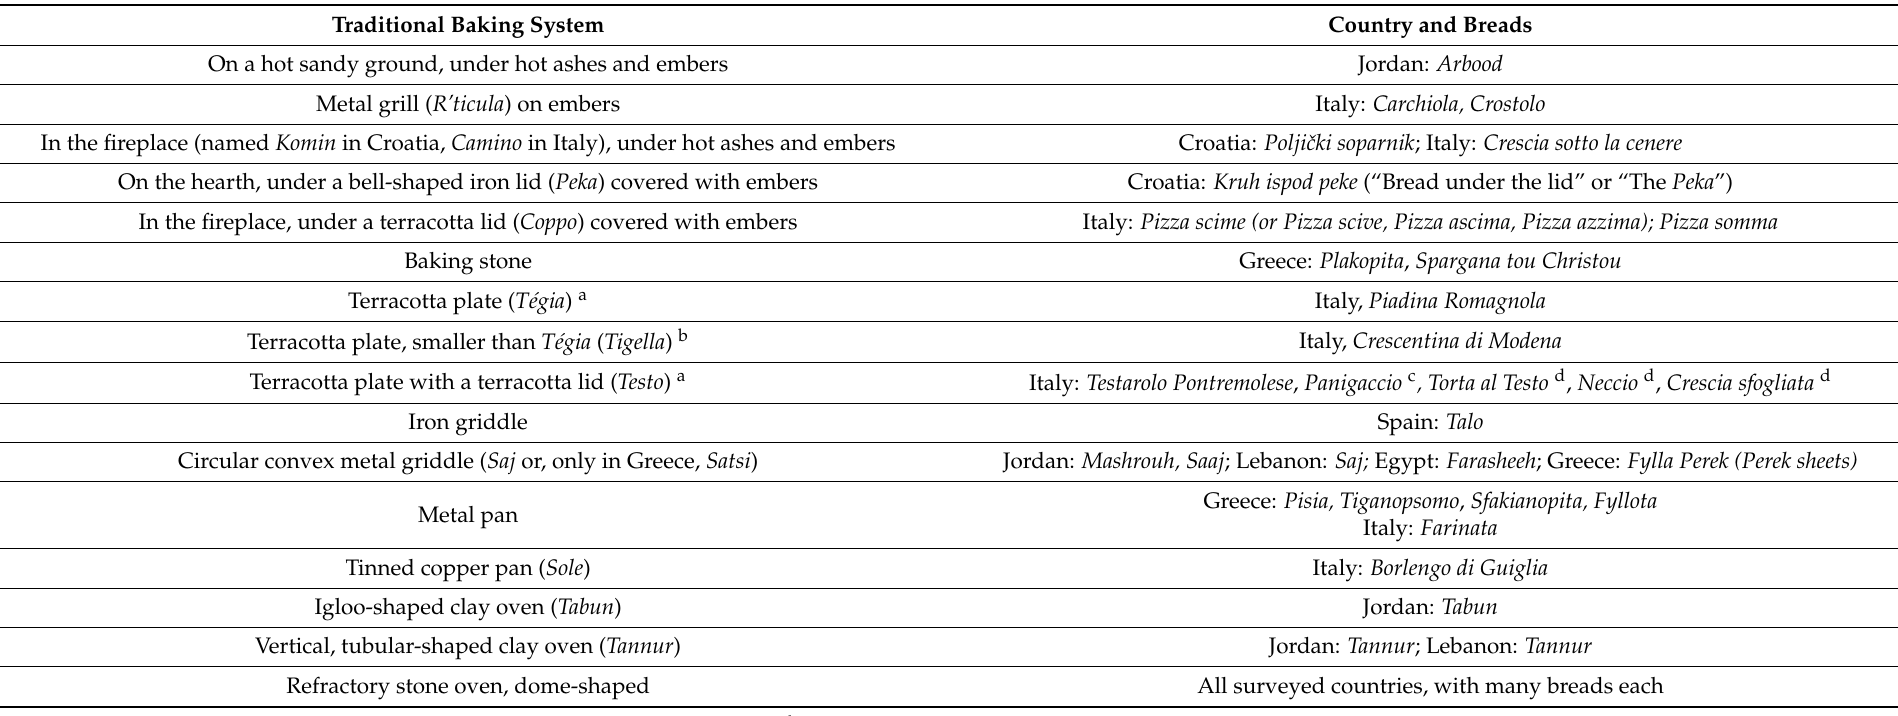
Table 7. Traditional baking systems used in the preparation of flat